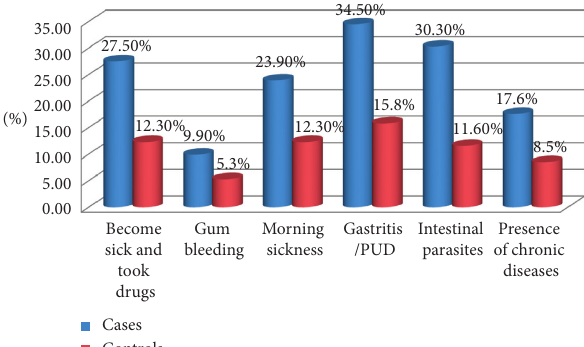
Figure 2: Percentage of disease-related characteristics of pregnant women attending ANC in public hospitals of West Shewa zone from February to April 2019. Table 3: Hygiene and sanitation-related characteristics of pregnant women attending ANC care at public hospitals of West Shewa zone from February to April 2019.